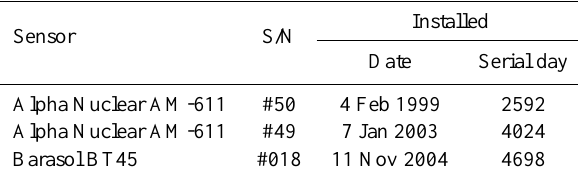
Table 1. Sensors used for radon monitoring at Roded site.